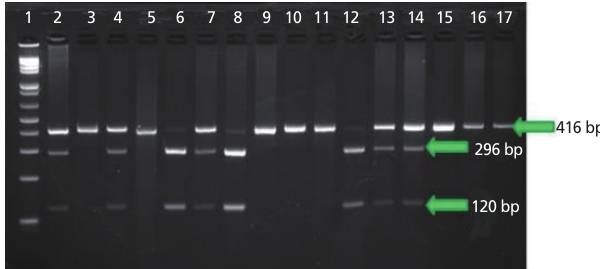
Figure 1. Agarose gel electrophoresis of polymerase chain reaction-restriction fragment length polymorphism test for the BCL2-associated X protein (BAX) gene. Lane 1 to 100 bp molecular weight ladder. Lanes 2, 4, 13, and 14 are classified as Carrier with 416, 296, and 120 bp; Lanes 3, 5, 9, 10, 11, and 16 are classified as mutant with 416 bp undigested band; Lanes 6, 8, and 12 are normal with 296 and 120 bp. Lane 17 is the positive control used.